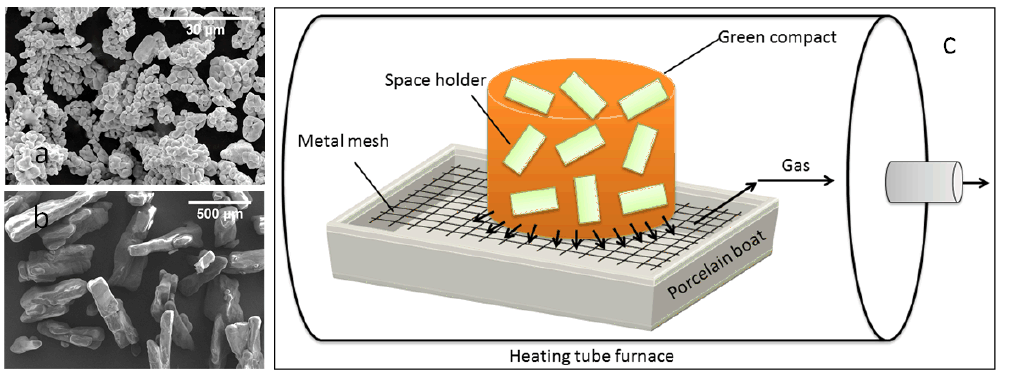
Figure 1. SEM images of ( a ) copper powder and ( b ) carbamide particles. ( c ) Schematic diagram of a green compact placed on a layer of metal mesh support in porcelain boat during the decomposition process of space holder in a heating tube furnace.